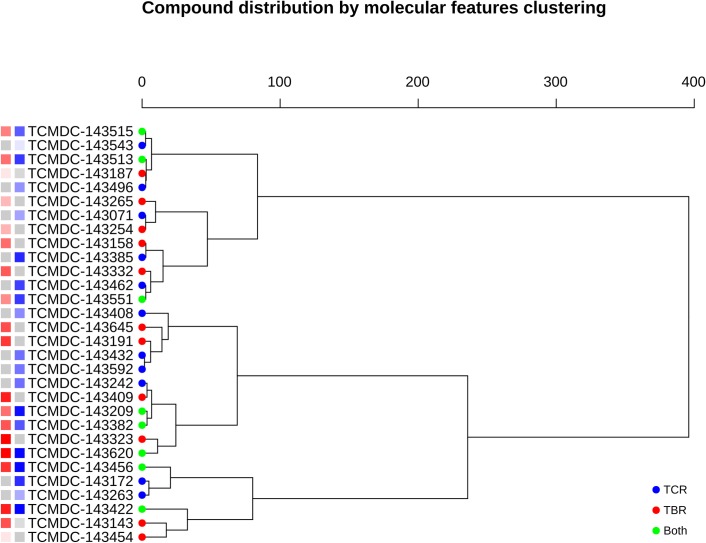
A dendrogram representing compound clustering using molecular features, and summarizing the activity distribution among tested MCPs.Squares next to the names give an idea of IC50 observed: the brighter the color, the lower the IC50. Red squares for TbMCP-1, blue squares for TcMCP-1, grey squares for non-active in TbMCP-1/TcMCP-1, accordingly.